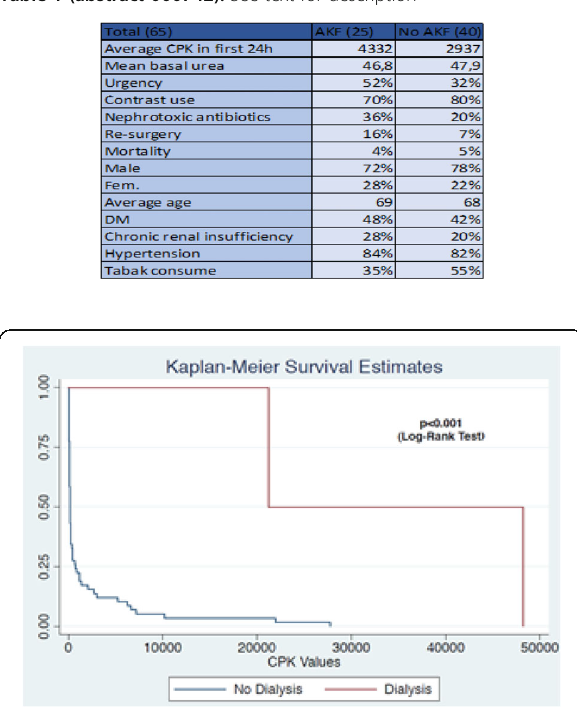
Table 1 (abstract 000742). See text for